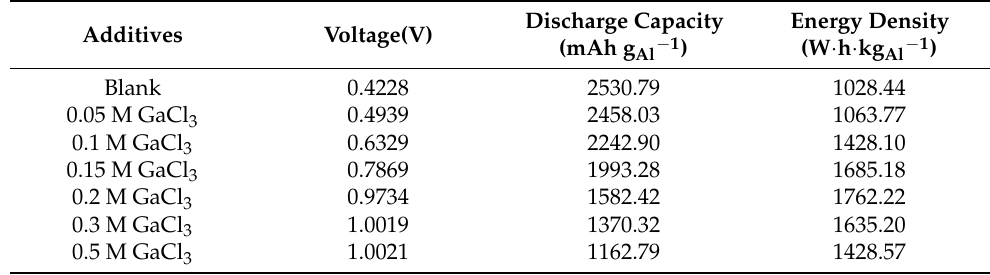
Figure 2. ( a ) Open-circuit potential of Al anode in 2 M NaCl electrolyte with different contents of GaCl 3 additive. ( b ) Discharge curves of Al-air batteries in 2 M NaCl electrolyte at 10 mA cm −2 without and with different contents of GaCl 3 additives. Table 2. Discharge performance of Al-air batteries in 2 M NaCl electrolyte at 10 mA cm −2 without and with different contents of GaCl 3 additives.